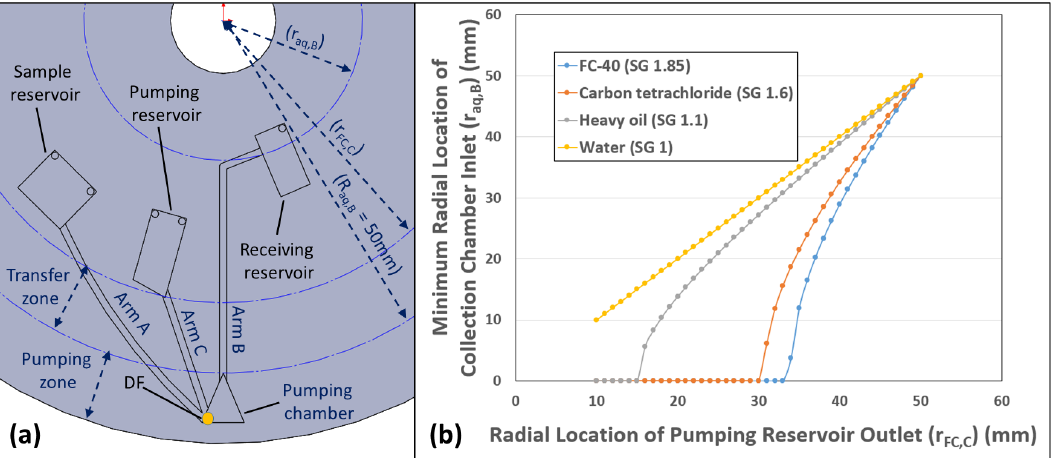
Figure 2. Effect of the location of the pumping reservoir and the density of the pumping liquid on the radial distance to which the sample can be pumped. Here, it is assumed that the sample is pumped from a chamber at or radially outward of 50 mm ( R aq,B ). ( a ) Basic pumping structure displaying reservoirs for the high-density pumping liquid and sample. Arm A, arm B, and arm C correspond to the inlet arm, outlet arm, and pumping liquid arm, as defined in Figure 1. ( b ) The location of the outlet of the reservoir ( r FC,C ) is on the minimum radial location of the inlet to the receiving reservoir ( r aq,B ), where a sample must be pumped centripetally from a radius of 50 mm. Here, should the pumping reservoir outlet be located at r FC,C = 40 mm, it might be expected that the sample can be pumped centripetally to r aq,B = 29 mm should the pumping liquid be FC-40, but only to 38 mm if the pumping liquid is typical heavy oil (SG 1.1). Should the outlet of the pumping reservoir ( r FC,C ) be located radially inwards of 33 mm, FC-40 can displace the aqueous sample to the centre of the rotation. At first (Figure 1a,b), the denser FC-40 in arm C is restrained by a DF barrier so the aqueous sample seeks equal filling levels in arms A and B to balance the hydrostatic pressures in each arm. Due to the large channel expansion, most of the water volume V aq will now reside in central channel B. Upon dissolution of the DF (Figure 1b,c) by the sample, FC-40 is introduced (Figure 1c) into the network. Owing to the density difference ρ FC > ρ aq , the immiscible FC-40 of volume V FC stays radially outwards, thus centripetally